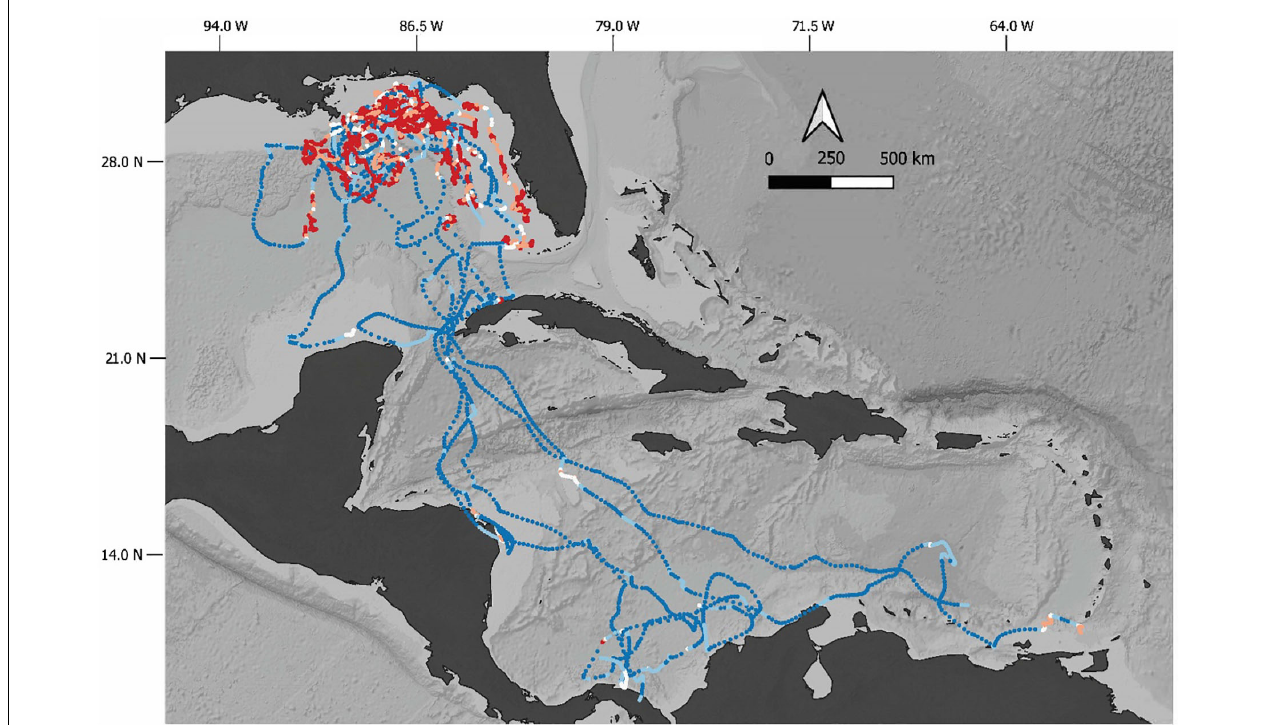
FIGURE 3 | Tracks and behavior states of leatherbacks along satellite tracks. Red represents foraging, blue represents migration, and orange/white/light blue represents searching/foraging.